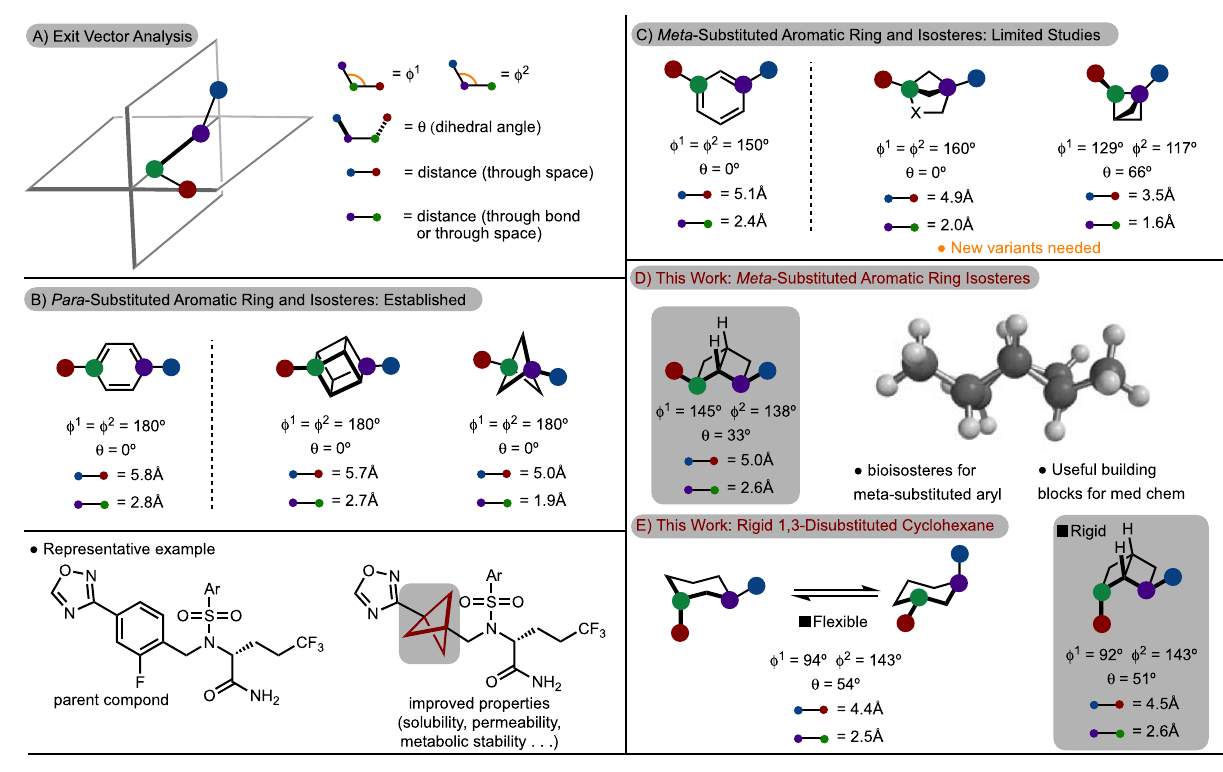
Fig. 1 | Background. A Exit vector analysis to establish the 3D positions of sub- stituents relative to each other. B Known aromatic ring isosteres for para -sub- stituted aromatic rings with a representative example. C Known aromatic ring